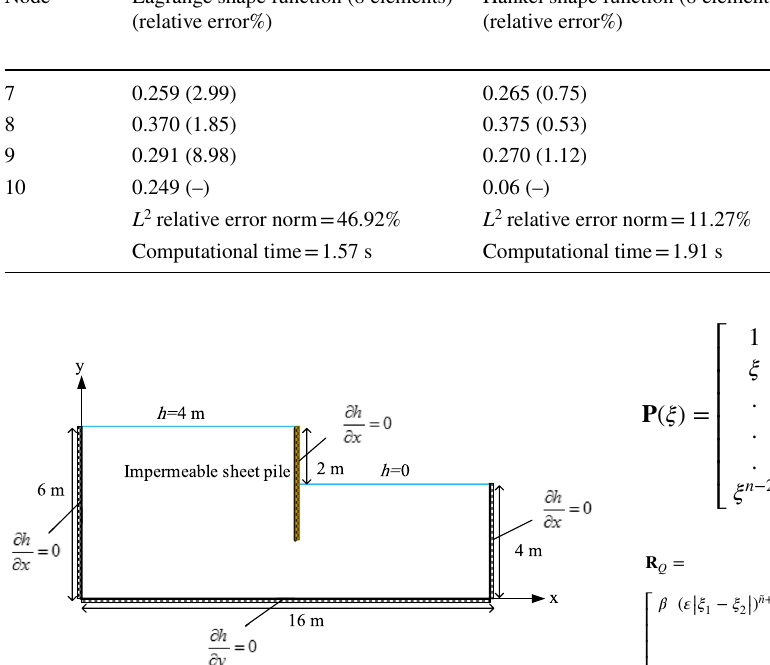
Solution with 2048 elements (rela- tive error%)